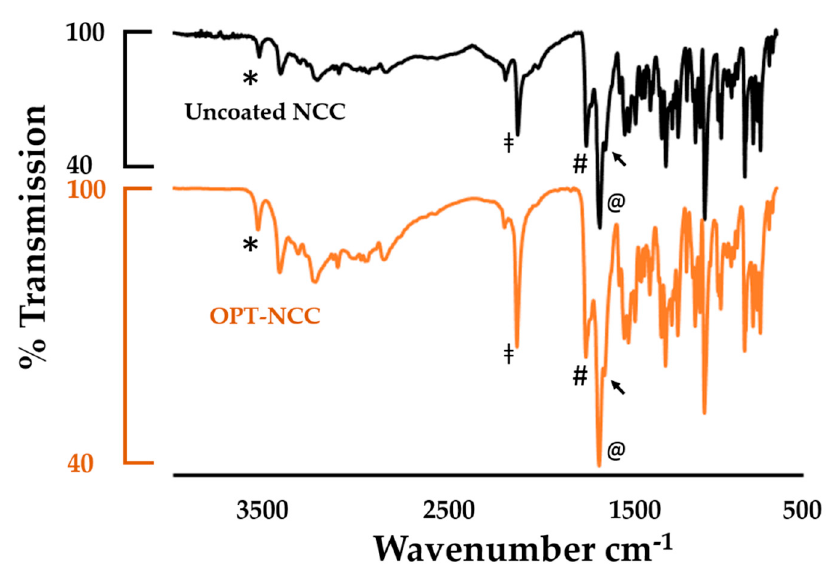
Figure 6. FTIR absorption spectra of the uncoated NCC (black) and the OPT-NCC (orange).